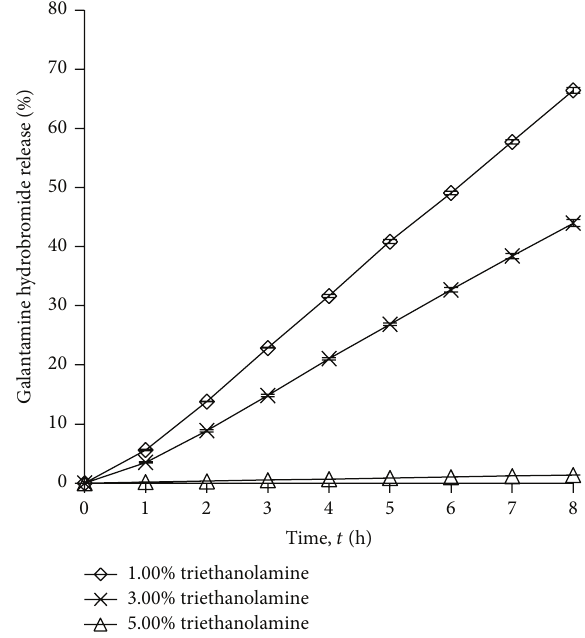
Figure 2: Drug release profile of gel drug reservoirs with different triethanolamine percentage (mean ± S.D.; 𝑛 = 3